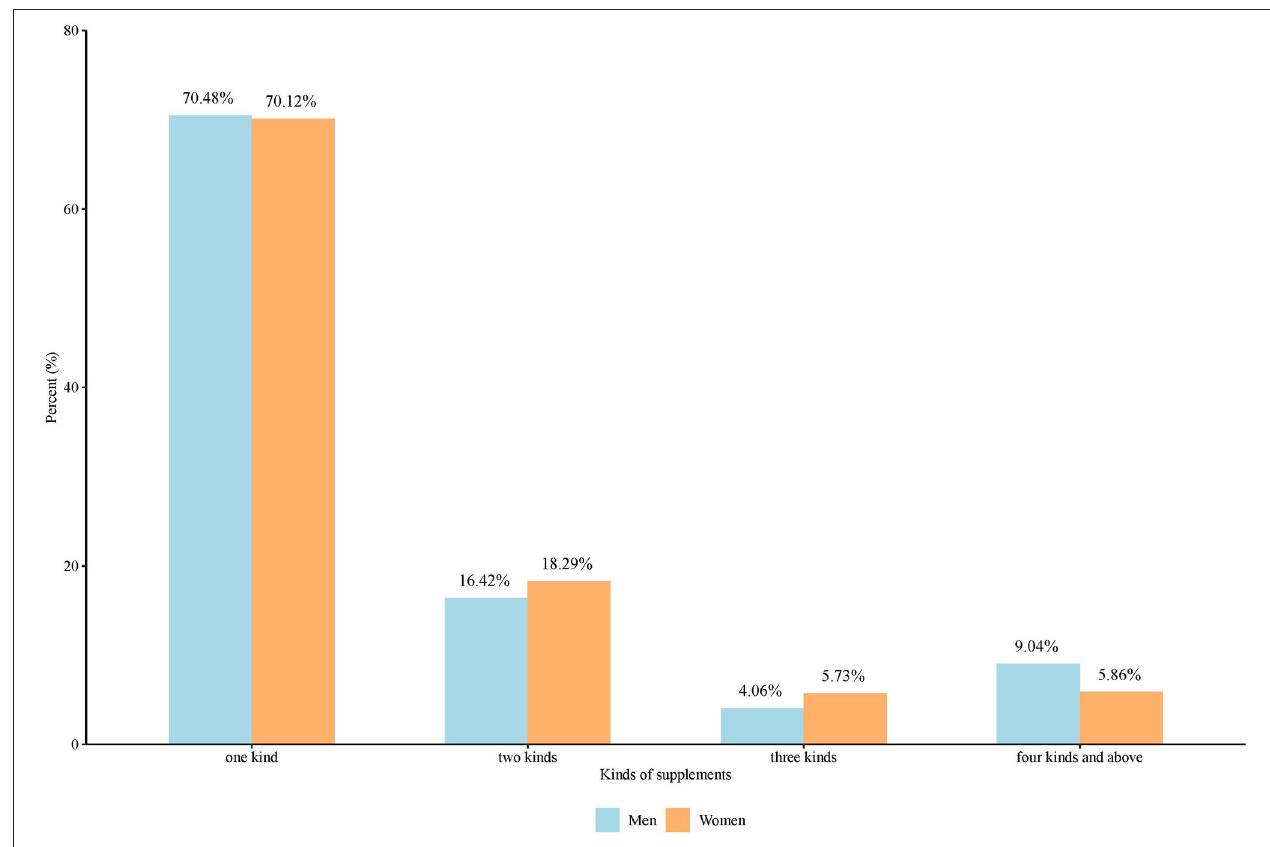
FIGURE 2 | Distribution of the number of supplements taken by